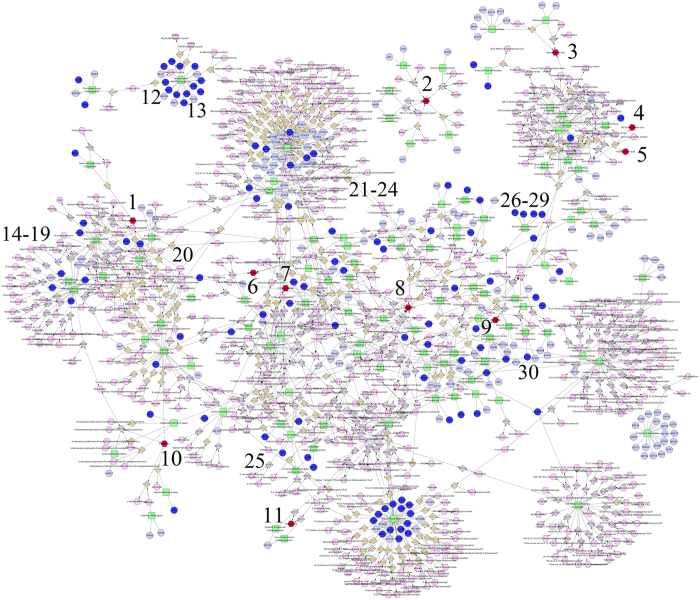
Fully connected network of metabolites and genes in our selected 7 pathways.The nodes in red indicated differential metabolites (1–11) and the nodes in blue indicated differentially expressed genes (12–30) in this study. The nodes in green indicated enzymes in these pathways. 1. 4-Trimethylammoniobutanoic acid. 2. L-Lysine. 3. Palmitic acid. 4. Oleic Acid. 5. Myristic acid. 6. L-Glyceric acid. 7. 21-Deoxycortisol. 8. Oxoglutaric acid. 9. L-Malic acid. 10. L-Histidine. 11. Aldosterone. 12. WHSC1. 13. EHMT2. 14–19. ALDH1B1, ALDH2, ALDH3B1, ALDH3B2, ALDH7A1, ALDH9A1. 20. MAOA. 21–24. CYP1A2, CYP2E1, CYP3A4, CYP19A1. 25. STS. 26–29. SDHA, SDHB, SDHC, SDHD. 30. ACAT1.